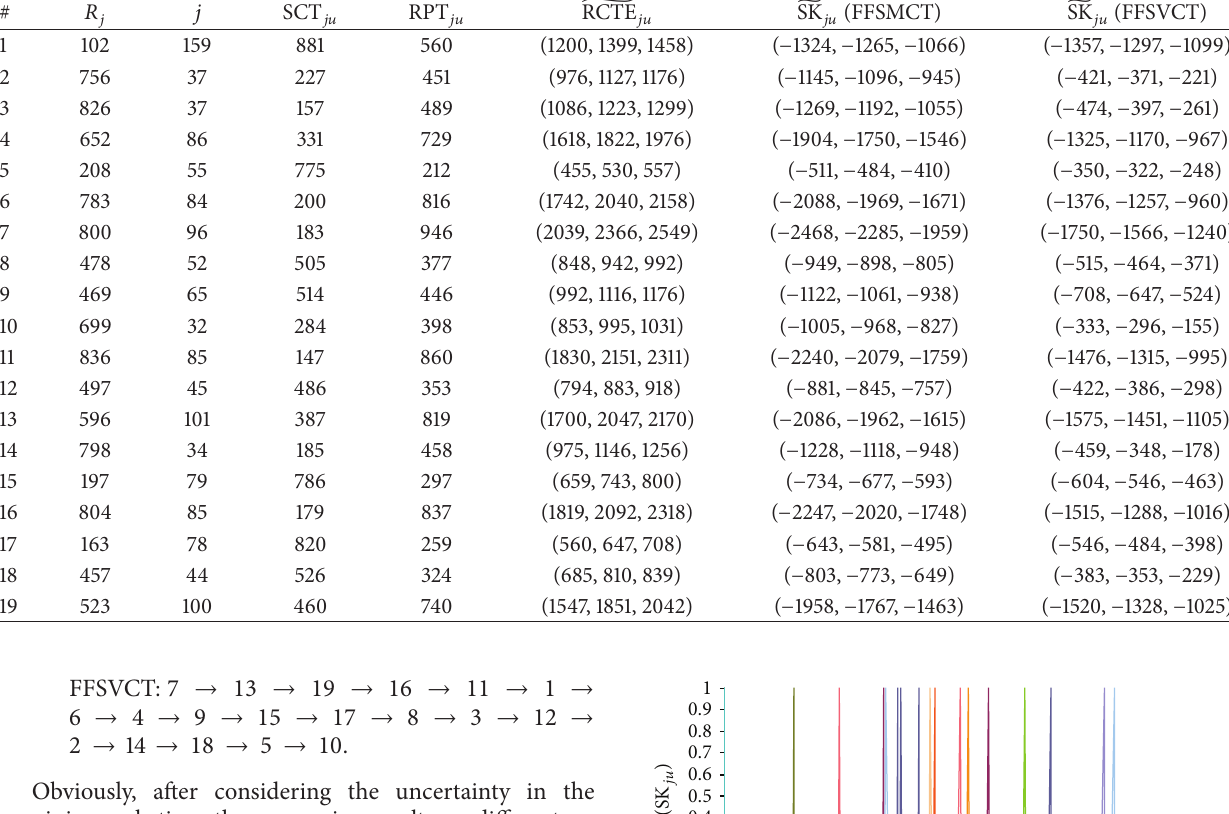
Table 6: The example with fuzzy remaining cycle times ( 𝜆 = 1.18).